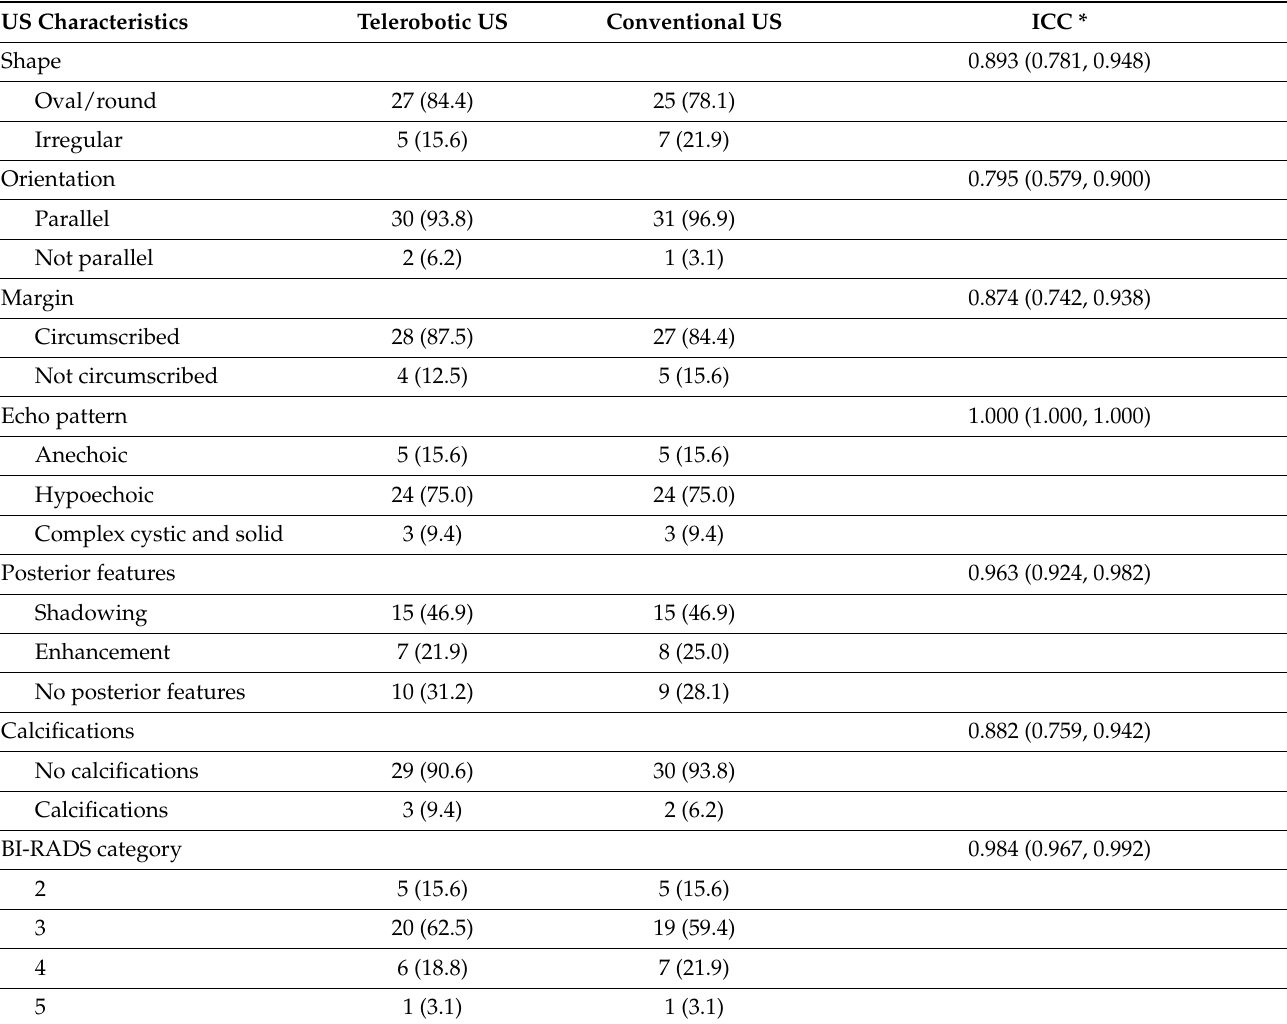
Table 5. Interobserver agreement in US features of the same breast nodules in Scenario A. Except were indicated, data in parentheses are percentages. *: Numbers in parentheses are 95% confidence intervals. Abbreviations: US: ultrasound; ICC: intraclass correlation coefficient.